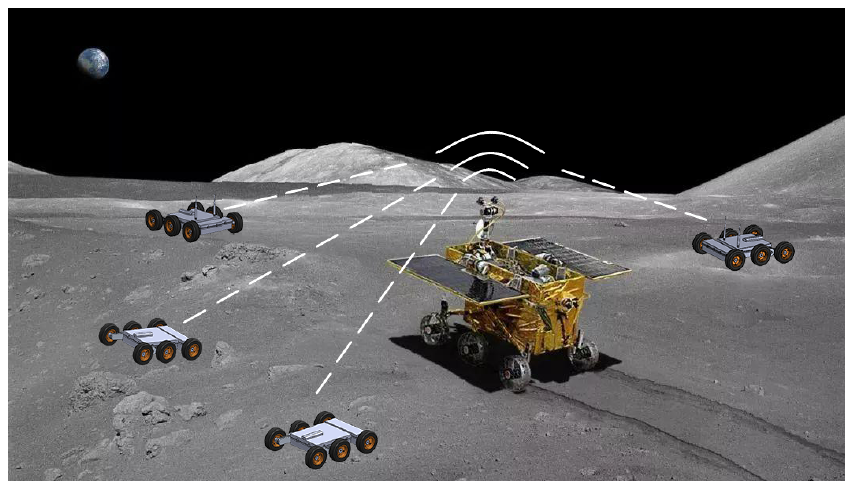
Figure 1. Small robots accompany a large robot in exploration.